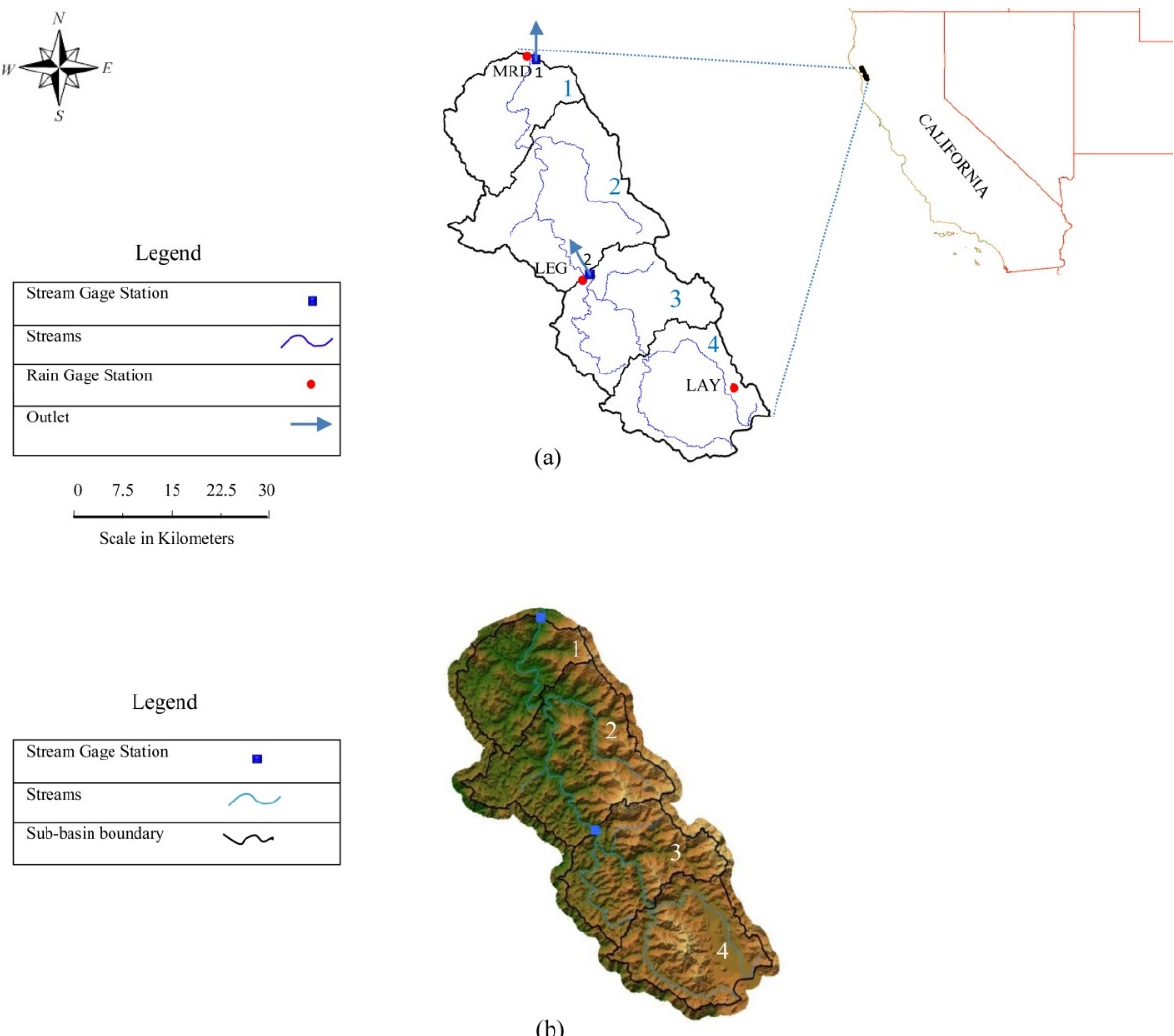
Figure 1. South Fork Eel River watershed at Miranda. ( a ) Situation map; ( b ) Geomorphological